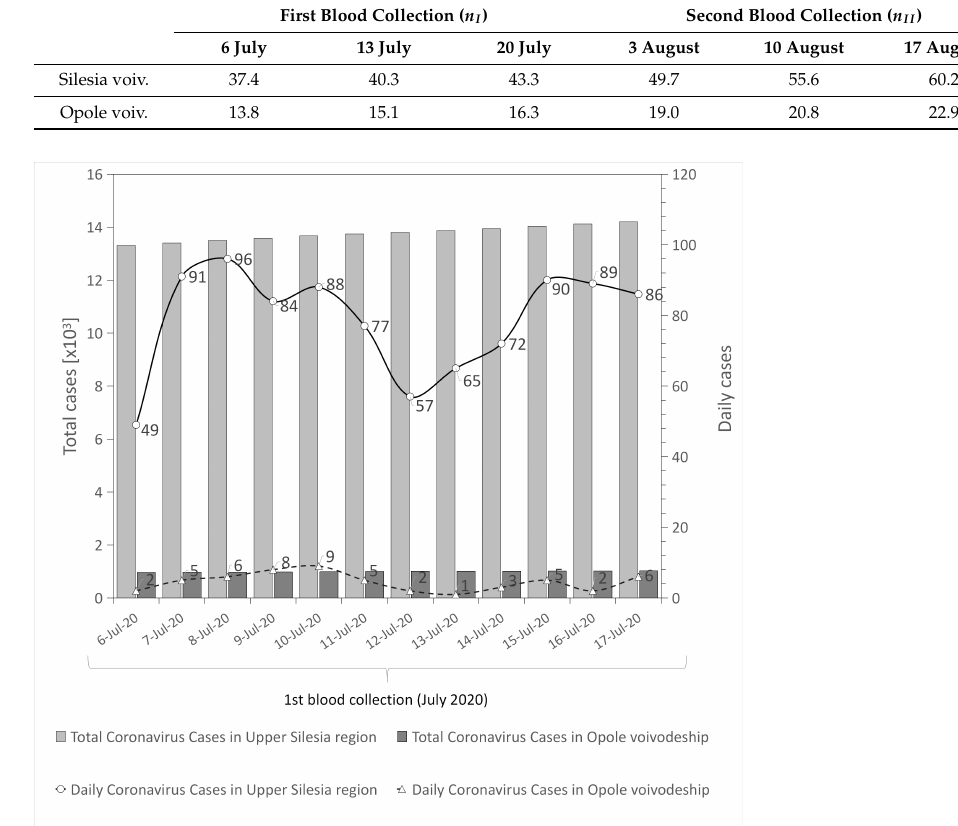
Table 6. SARS-CoV-2 testing (RT-PCR) per 1000 individuals in two different regions of Poland.